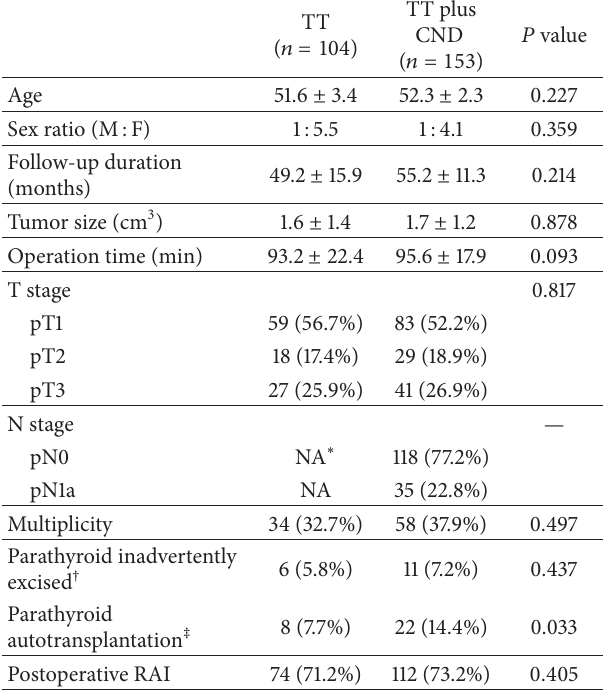
Table 1: Demographic and perioperative data.